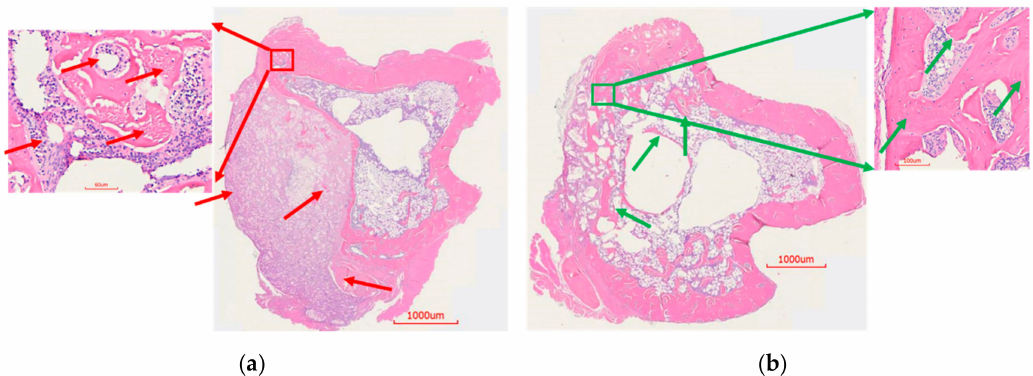
Figure 9. H&E staining of rat bones from k-wire osteomyelitis model. ( a ) H&E staining of control rat bone. There was bone growth but with narrowing of marrow space. In places, there was thickening of bone. A big fibrous capsule with inflammatory cells was visible. ( b ) Bone from the treatment group rat showed ongoing healing of the bone. New bone formation was visible in the defect. Osseointegration was seen as the degradation of the ABVF allowed new bone to grow